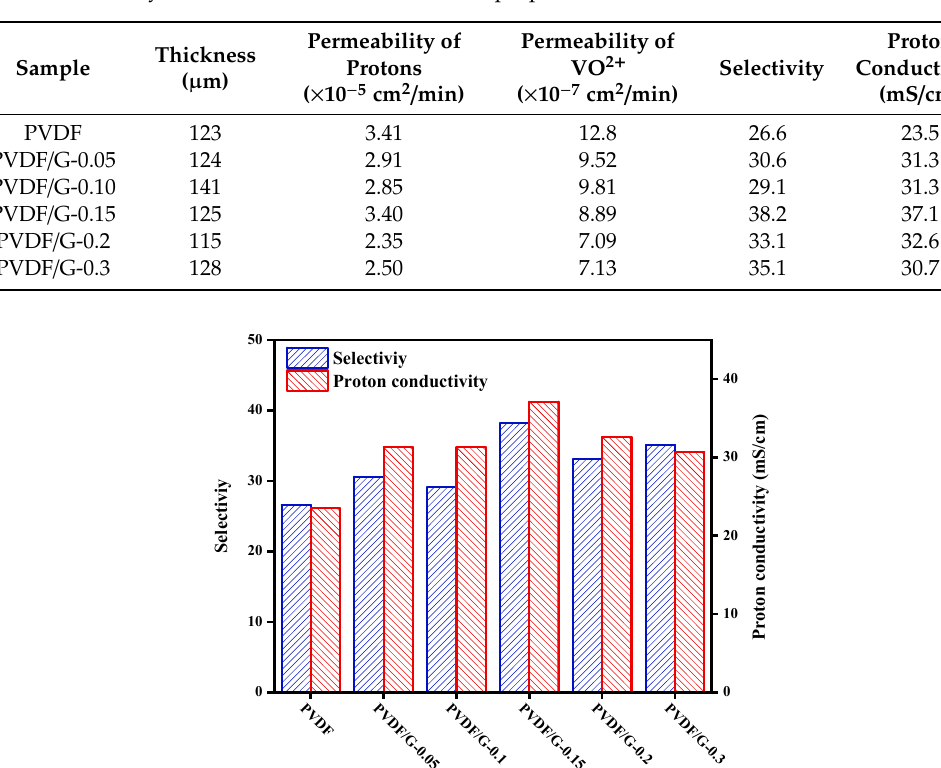
Table 1. Physicochemical and electrochemical properties of PVDF and PVDF / G membranes.